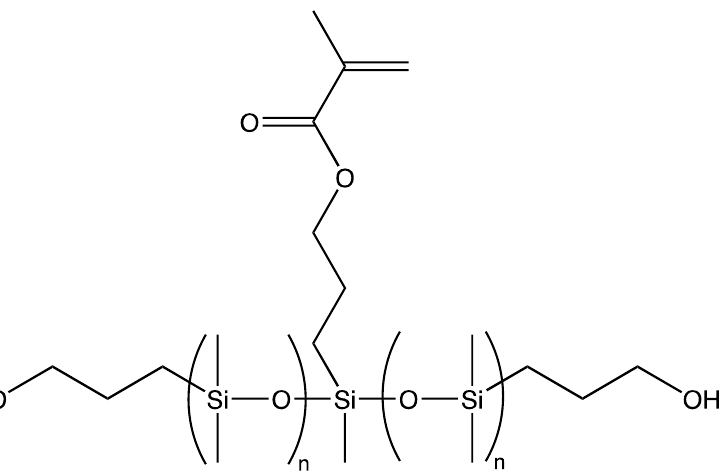
Scheme 8. Carbinol terminated telelechelic with macromeric methacrylate functionality.